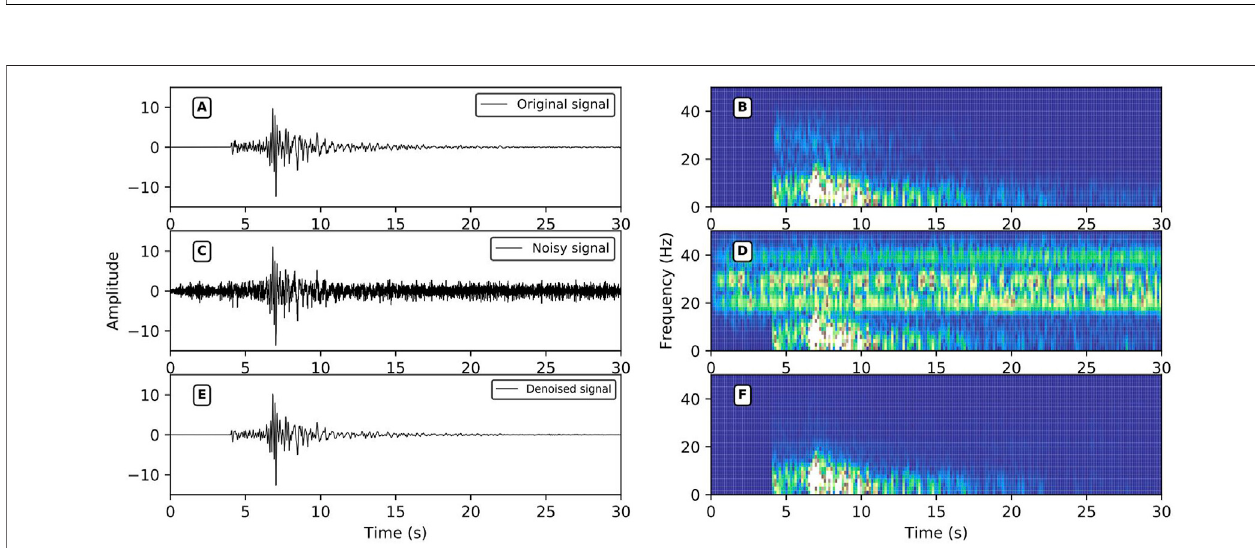
FIGURE 7 | Narrow-band noise reduction performance. (A,C,E) are the original signals, the noise signal, and the signal after noise reduction in the time domain; (B,D,F) are the time-frequency domain data of (A,C,E) ; the signal SNR after adding noise (cid:1) 0.50 dB, r (cid:1) 0.7087, SNR after noise reduction (cid:1) 16.54 dB, r (cid:1) 0.9899.